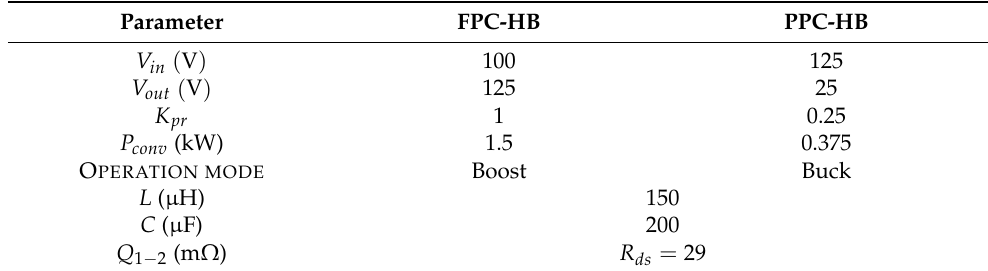
Table 2. Estimated design parameters for each single-inductor topology.